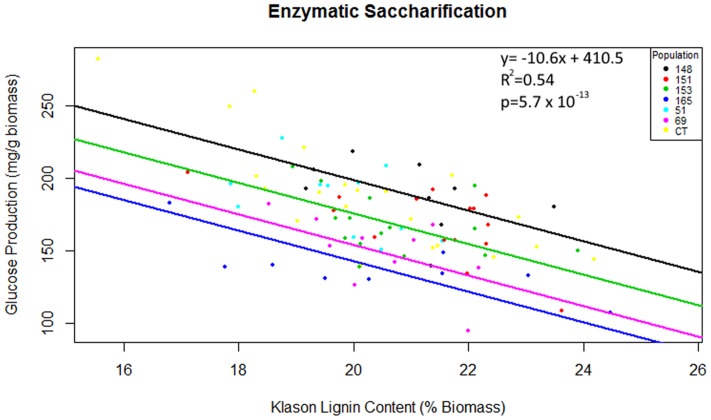
Total glucose production as predicted by population and Klason lignin content. Glucose production is expressed as mg of glucose released after 48 h of enzymatic hydrolysis per g of raw biomass and Klason lignin is expressed as a percentage of dry biomass. Numeric codes for each population are included within Table 2. Each colored regression line represents populations whose intercept is significantly different (P < 0.05) from the overall regression (black line). CCV, Corymbia citriodora subspecies variegata; CT, Corymbia torelliana.